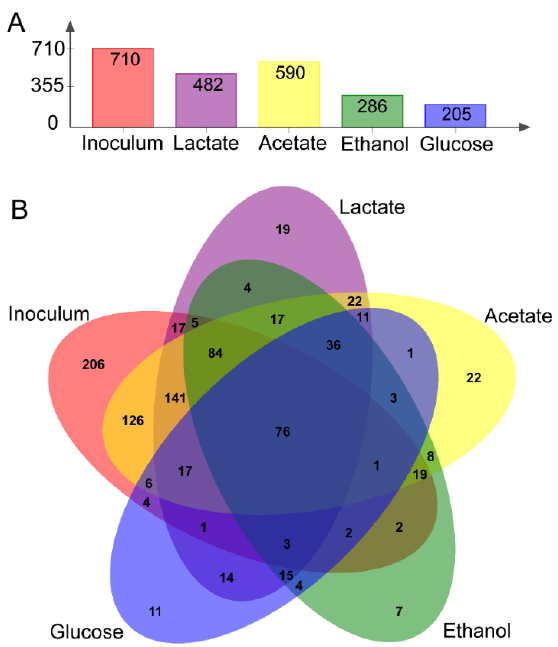
Figure 5. The number ( A ) and Venn diagram analysis ( B ) of the operational taxonomic unit (OTU) of these bioelectroactive biofilms enriched with different energy substrates.